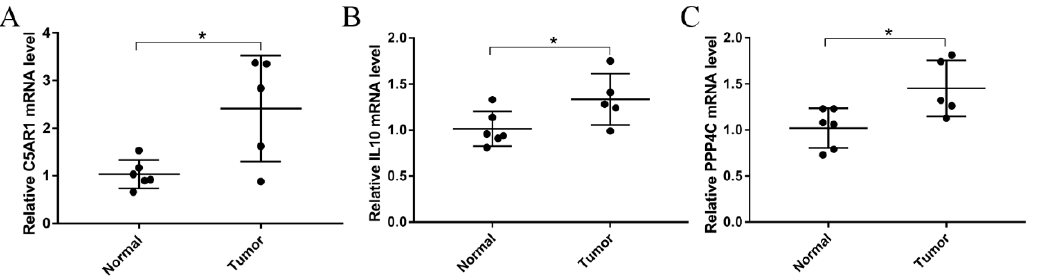
Figure 8. Relative mRNA levels of ( A ) C5AR1, ( B ) IL10, and ( C ) PPP4C in GBM (n = 5) were signif- icantly higher than in normal peritumoral tissues (n = 6) (Student’s t -test, * p < 0.05).